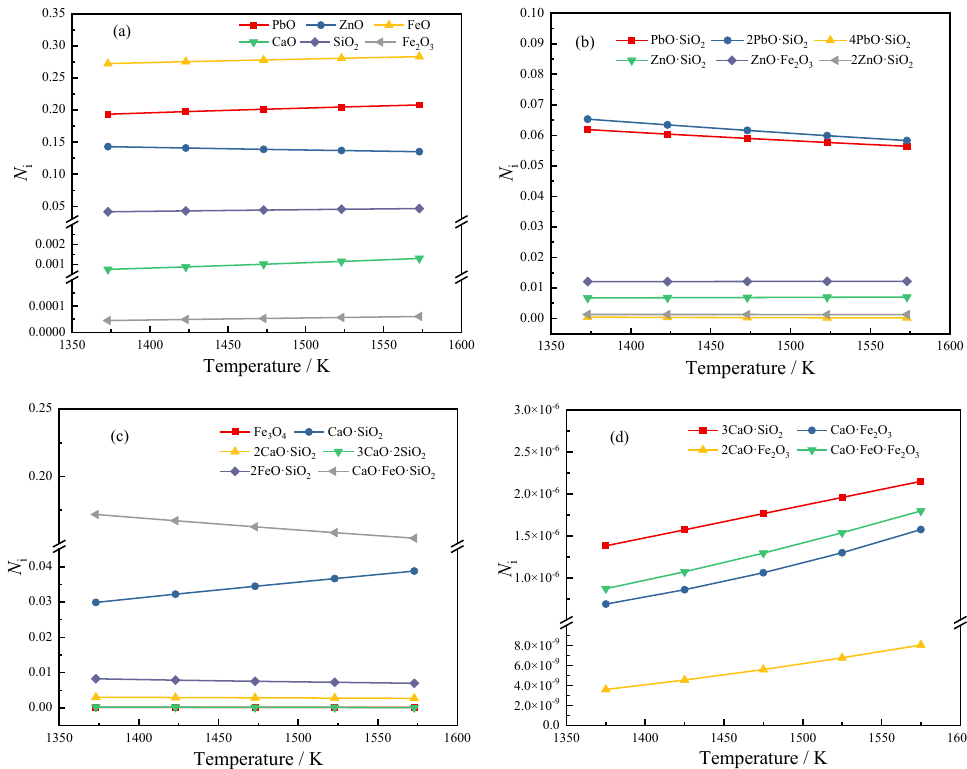
Figure 4. Activity of each structural unit at different temperatures: ( a ) initial component; ( b ) lead-zinc compound; ( c ) some complex molecules of iron-silicon-calcium salt; ( d ) some complex molecules with extremely low activity.